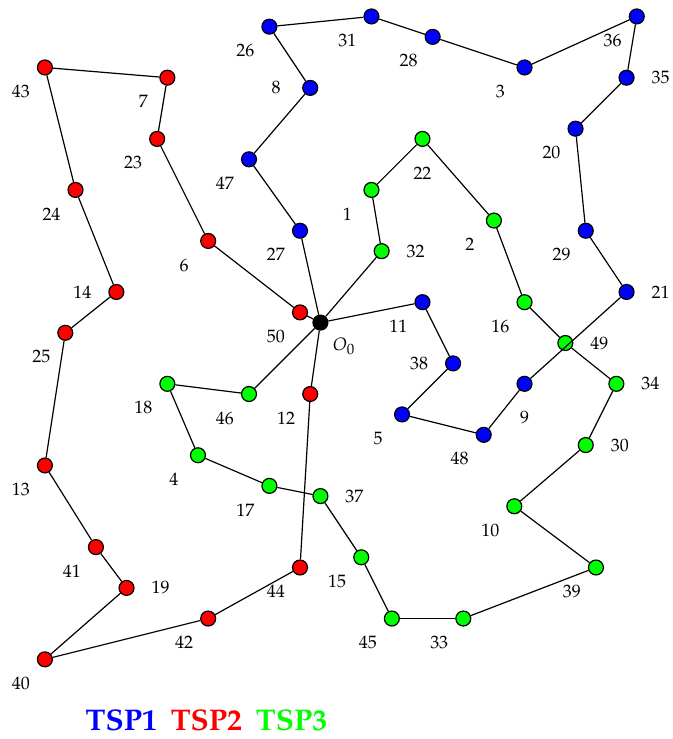
Figure 5. Tour for